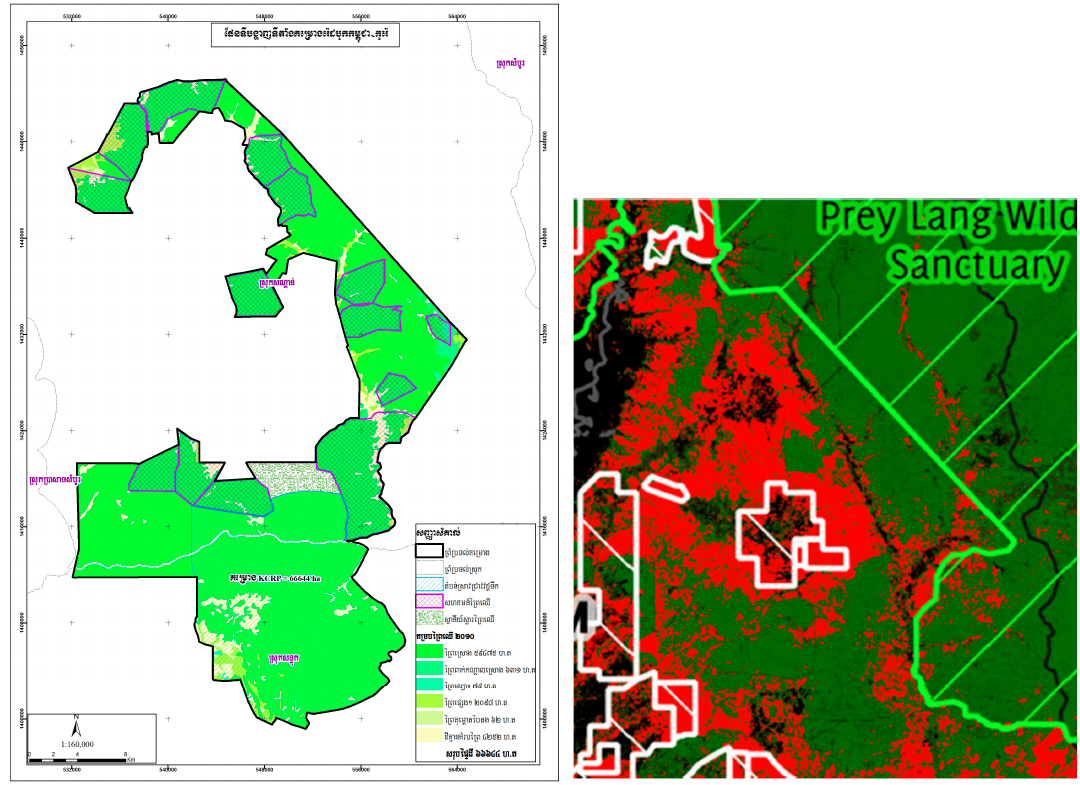
Figure 4. T-REDD project map #1 community forests (CFs) are outlined in dark green ( left ). Project area on deforestation map ( right ).